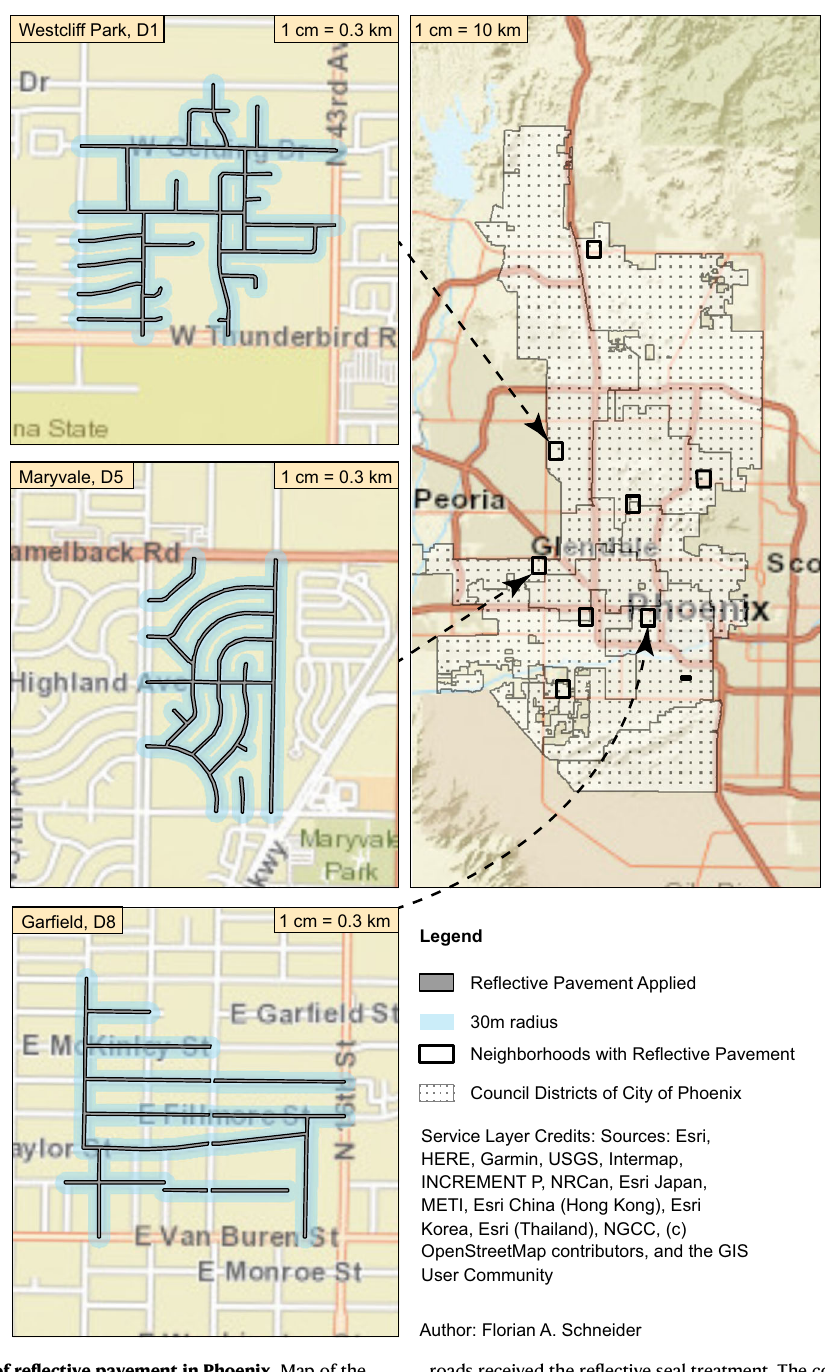
Fig. 2 | Areas of application of re fl ective pavement in Phoenix. Map of the Council Districts (D1 – D8) within the City of Phoenix (right), the neighborhoods where CoolSeal was applied (black rectangles), and a close-up for those neigh- borhoods where in-situ measurements were performed (left). Blue